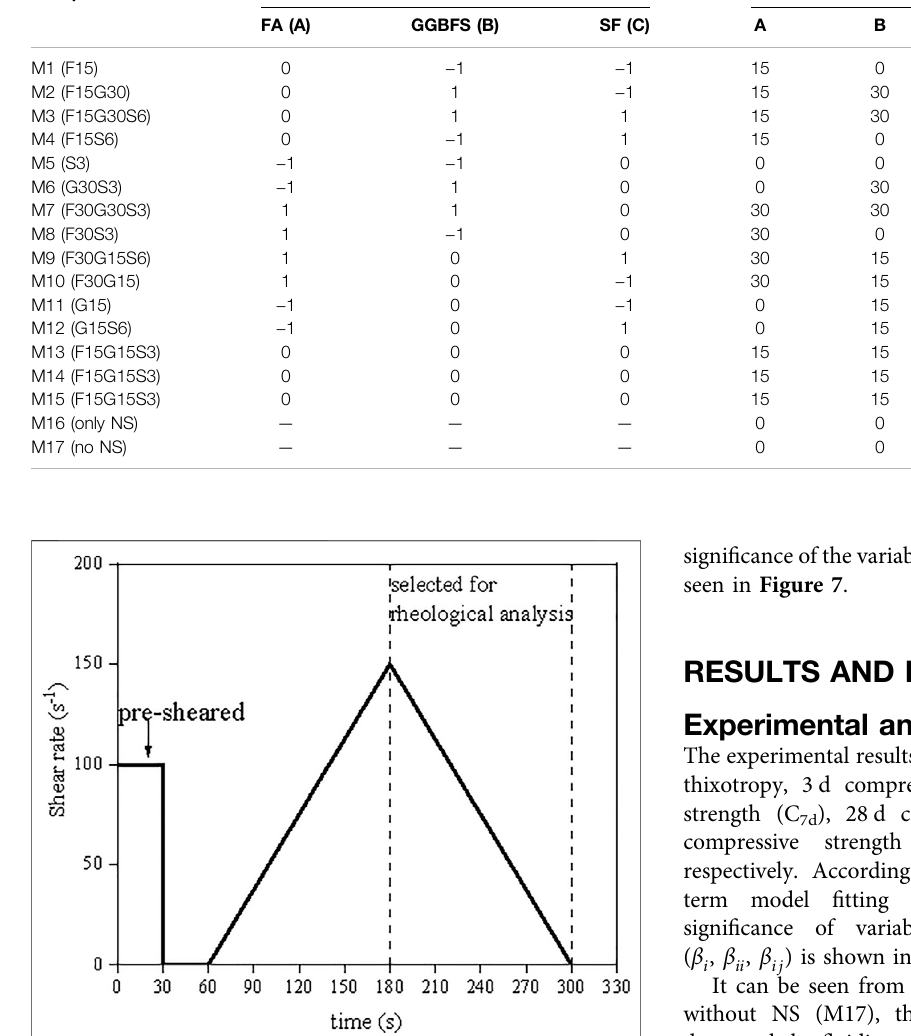
TABLE 3 | Mix proportion of nano-silica modi fi ed cement-based paste containing SCMs. Groups Coded values